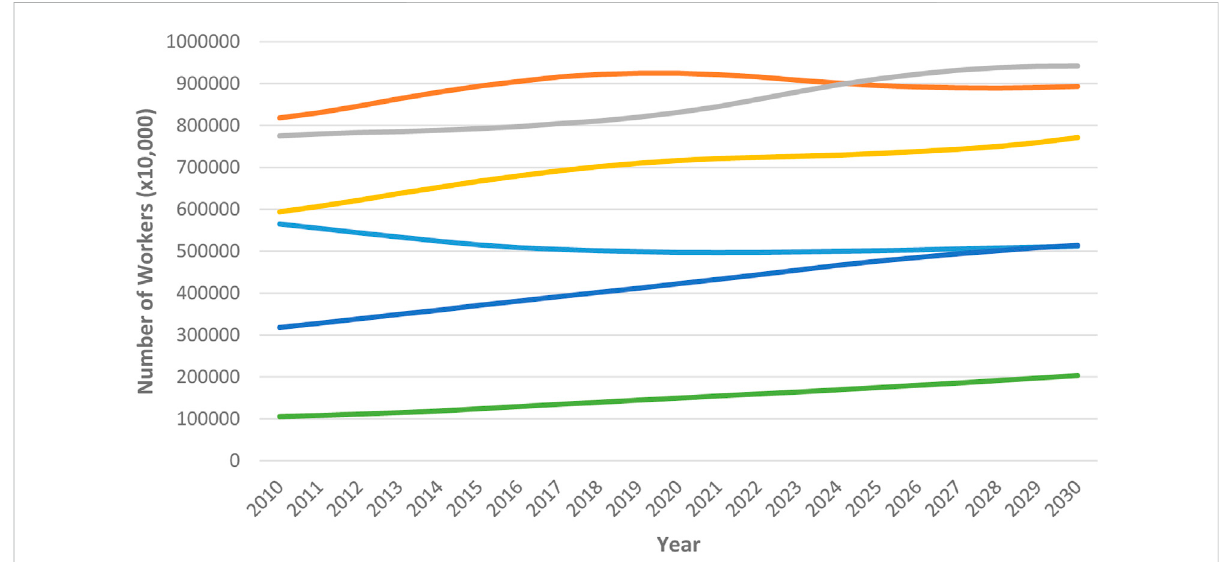
FIGURE 1 Workforce trends (thousands-annual) against different age groups